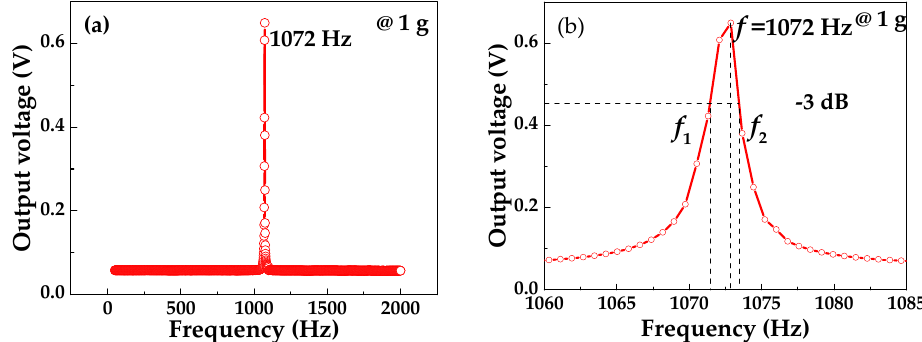
Figure 7. Relationship curve between output voltage and excitation frequency: ( a ) resonant frequency; ( b ) quality factor. Table 1. Theoretical calculation parameters of resonance frequency.